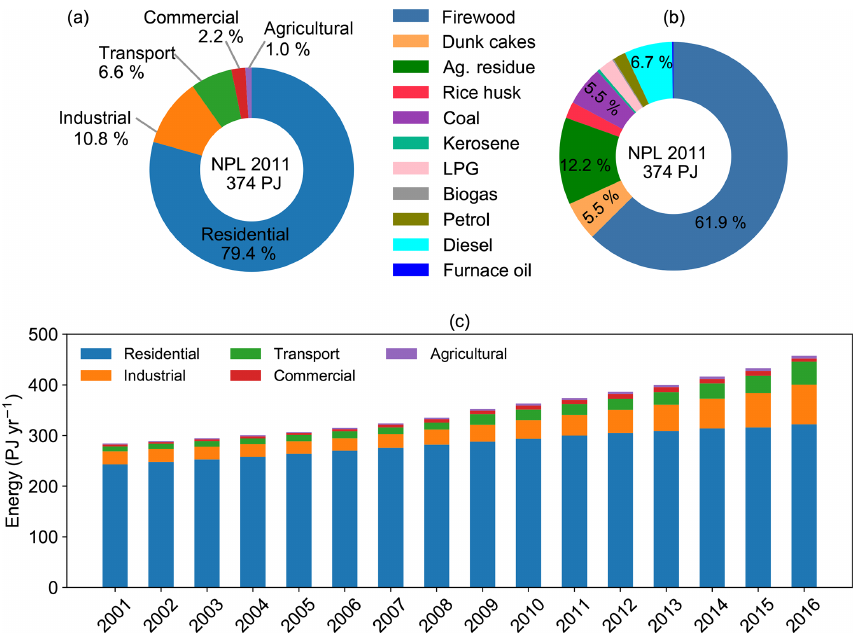
Figure 2. (a) National sectoral energy consumption, (b) contribution of fuel type to national energy consumption estimated for 2011 and (c) energy consumption trend for the period